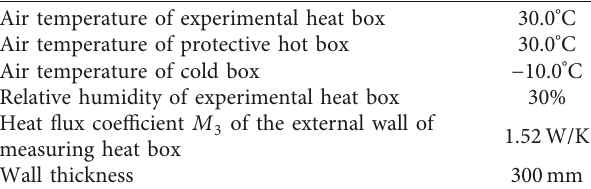
Table 5: Initial parameters used for the thermal